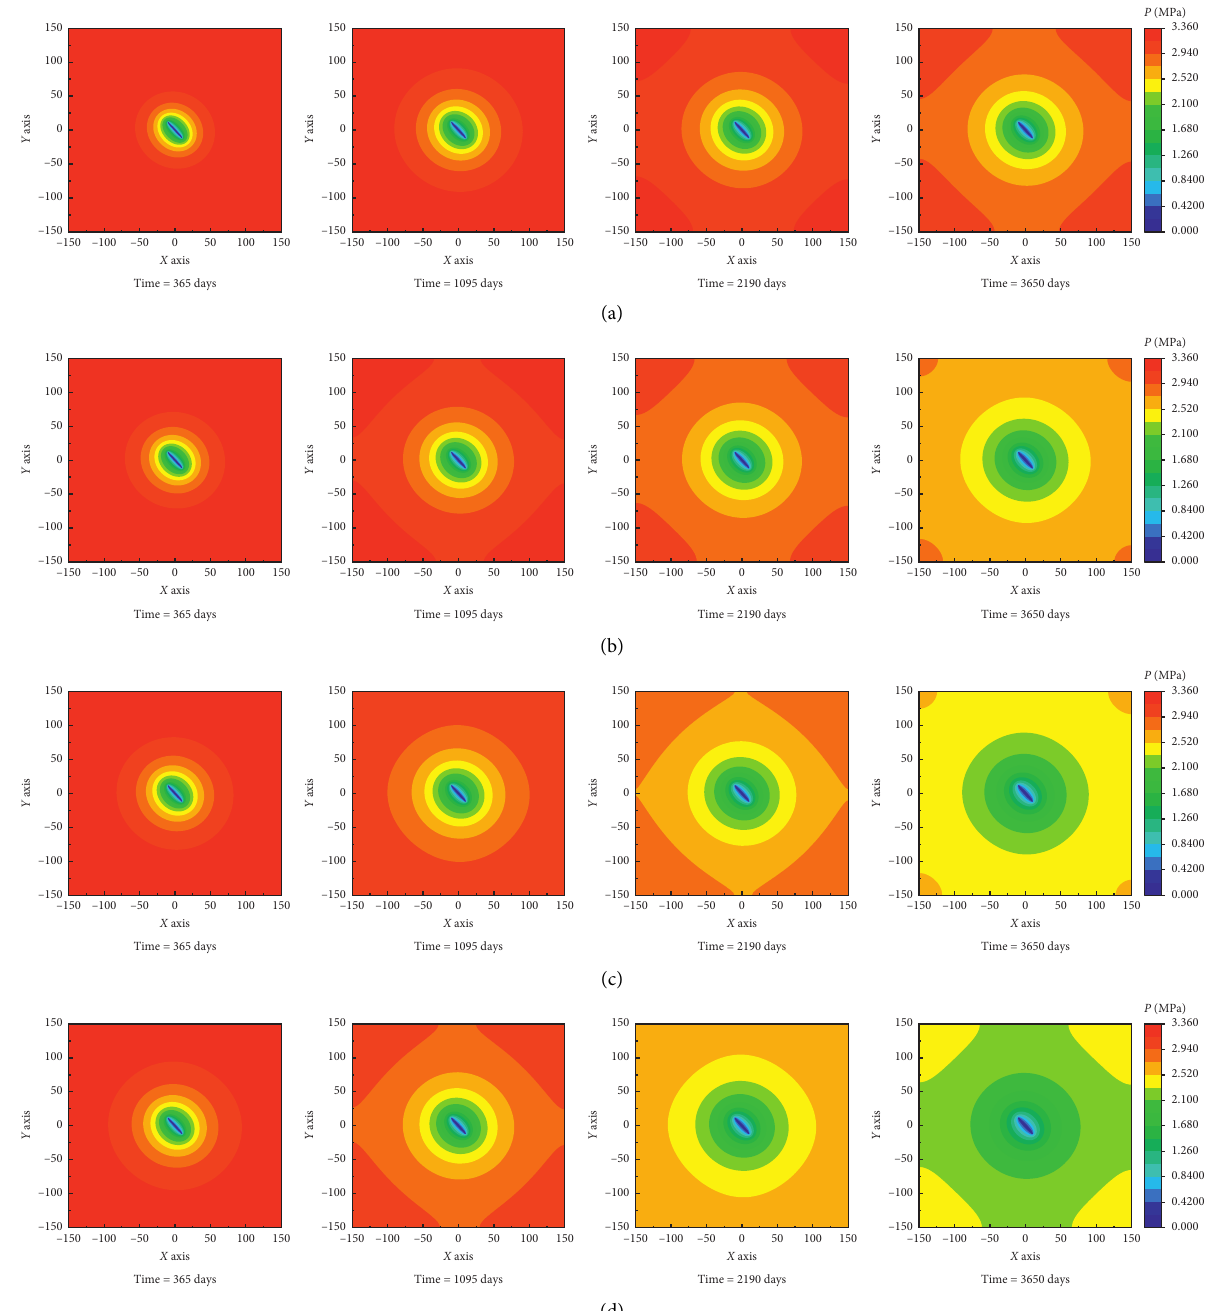
� 5 × 10 − 17 m 2 . (b) k � 9 × 10 − 17 m 2 . 0 0